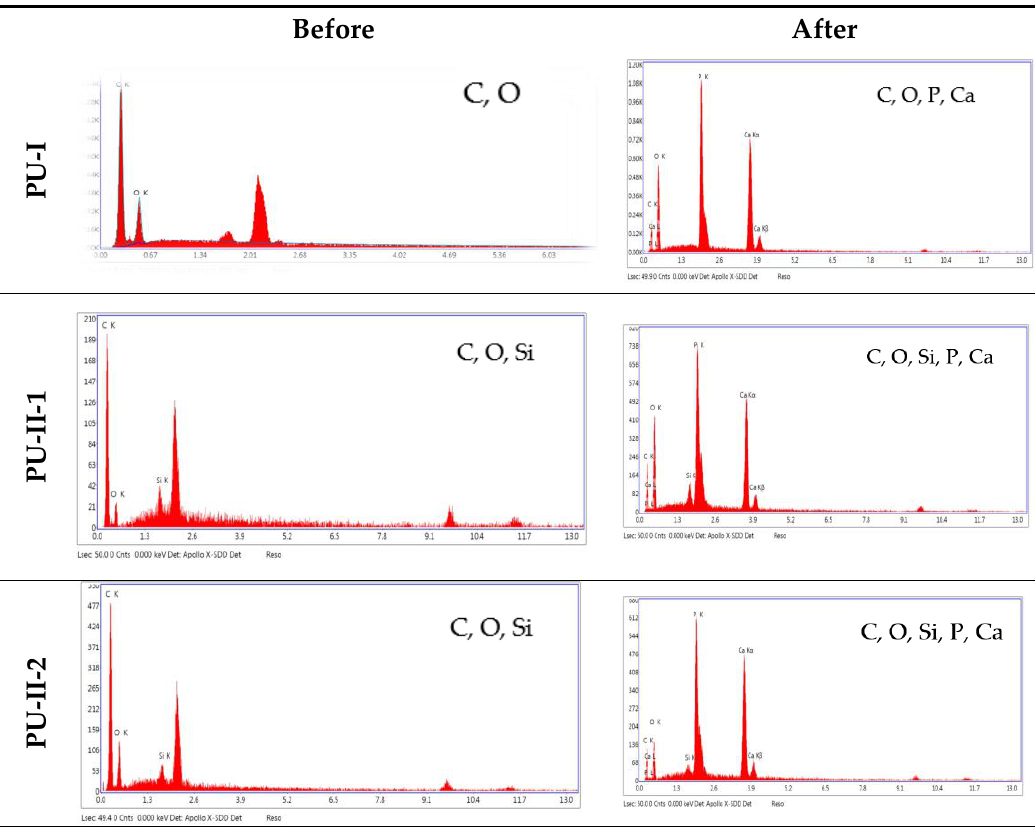
Figure 8. The EDX spectra of non-crosslinked and PVA-crosslinked PURs before and after calcification